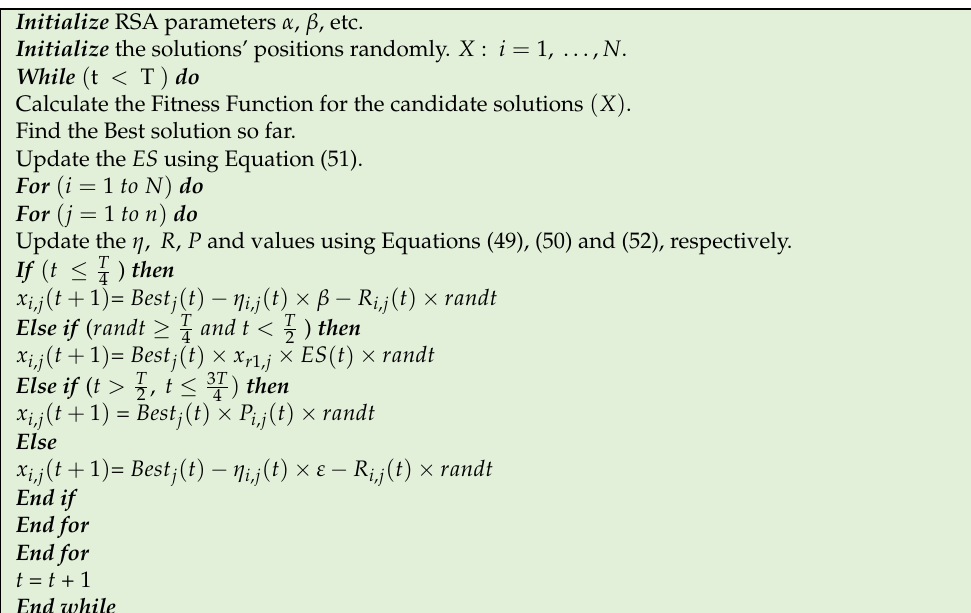
Table A3. Pseudo-code of RSO